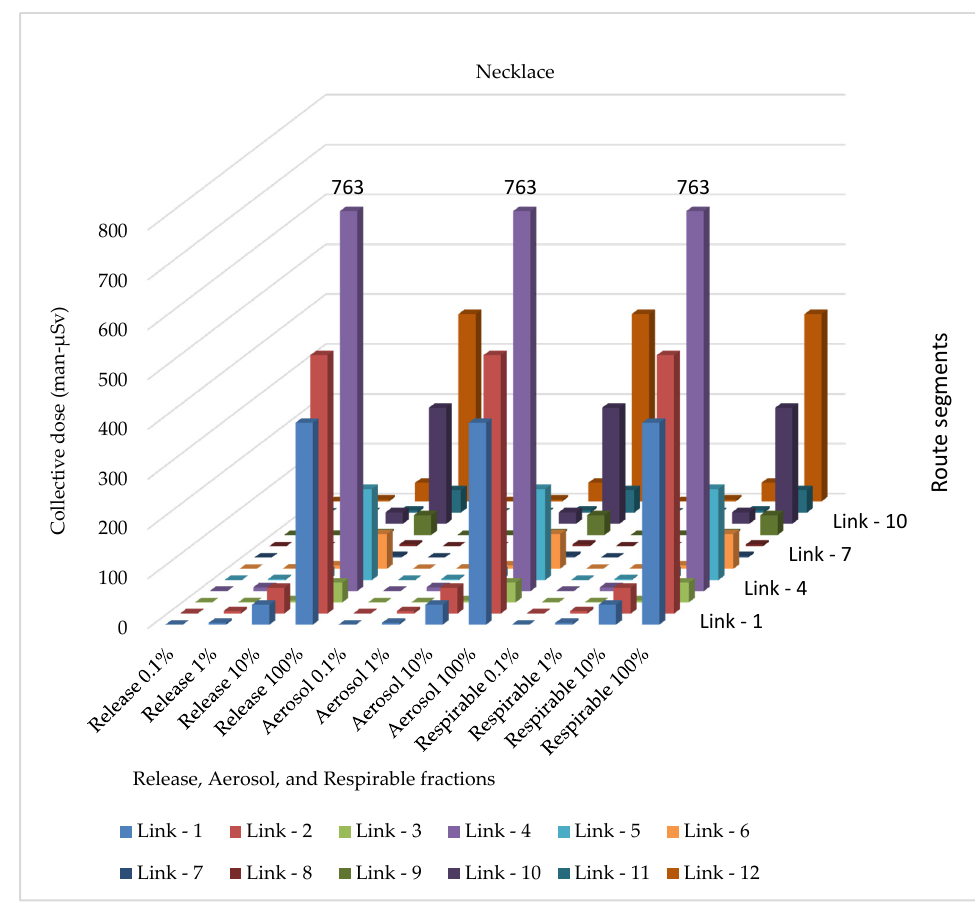
Figure 8. Sensitivity analysis result of necklace (consumer product).